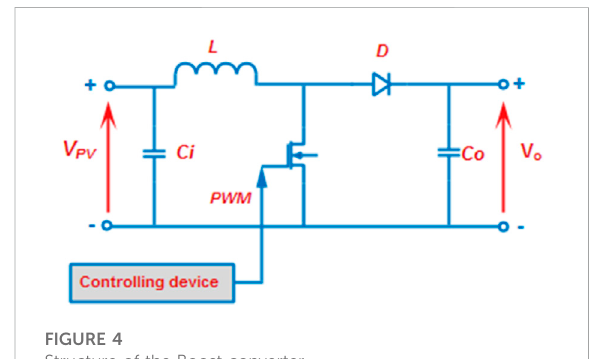
FIGURE 4 Structure of the Boost converter.